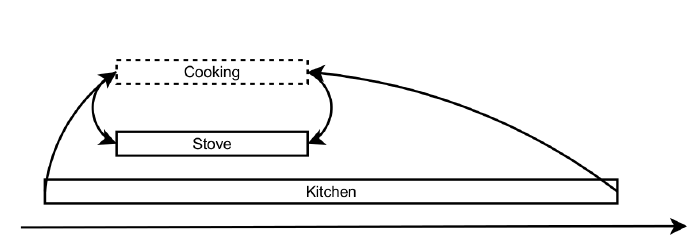
Figure 2. Inferring “cooking”